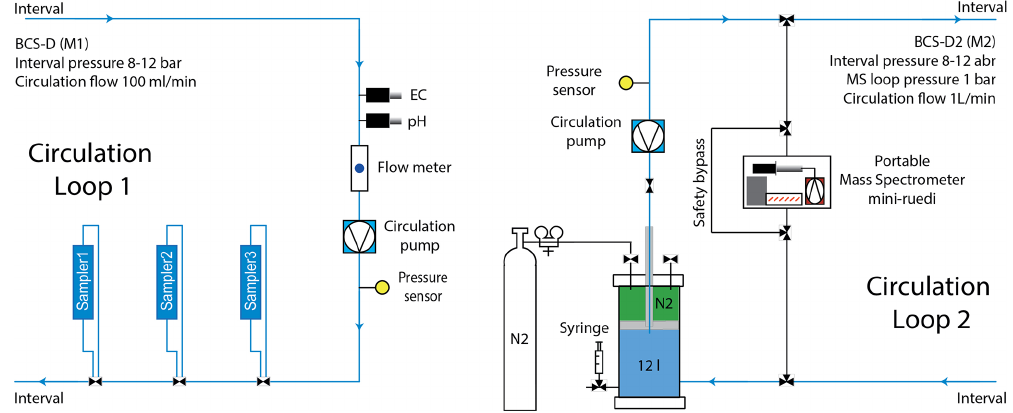
Figure 7. Circulation loops for the CS-D experiment (modified after Solexperts AG, Switzerland).